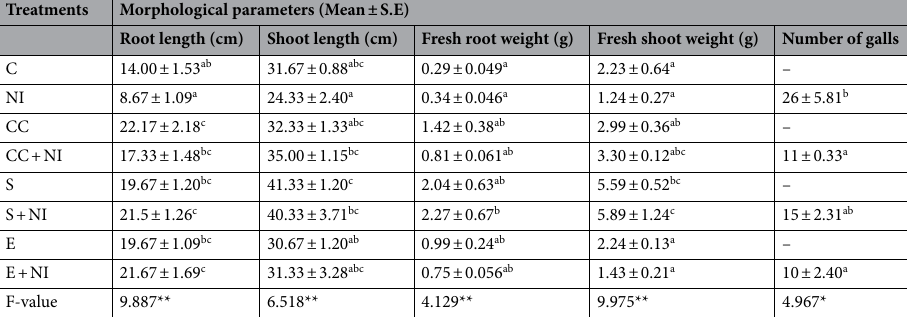
Table 1. Morphological parameters of M. incognita inoculated 60 days old tomato plants treated with S. hydrogenans strain DH-16. Different treatments are represented as C (control), NI (nematode inoculated), CC (culture cells), CC + NI (culture cells + nematode inoculated), S (supernatant), S + NI (supernatant + nematode inoculated), E (crude extract), E + NI (crude extract + nematode inoculated). Results are given in mean ± standard error and F-value * depicts significant difference at p ≤ 0.05. ** indicates significant difference at p ≤ 0.01 as per Tukey’s test. Letters a, b, c depicts significant difference among treatments and same letters depicts no significant